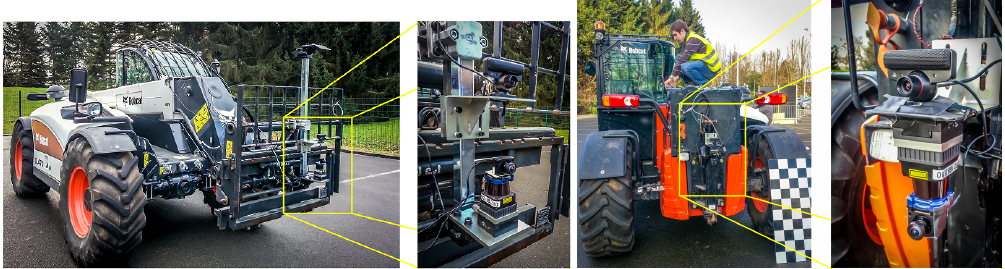
Figure 2. The telescopic forklift Bobcat TL470: Real images of the acquisition system setup in two different